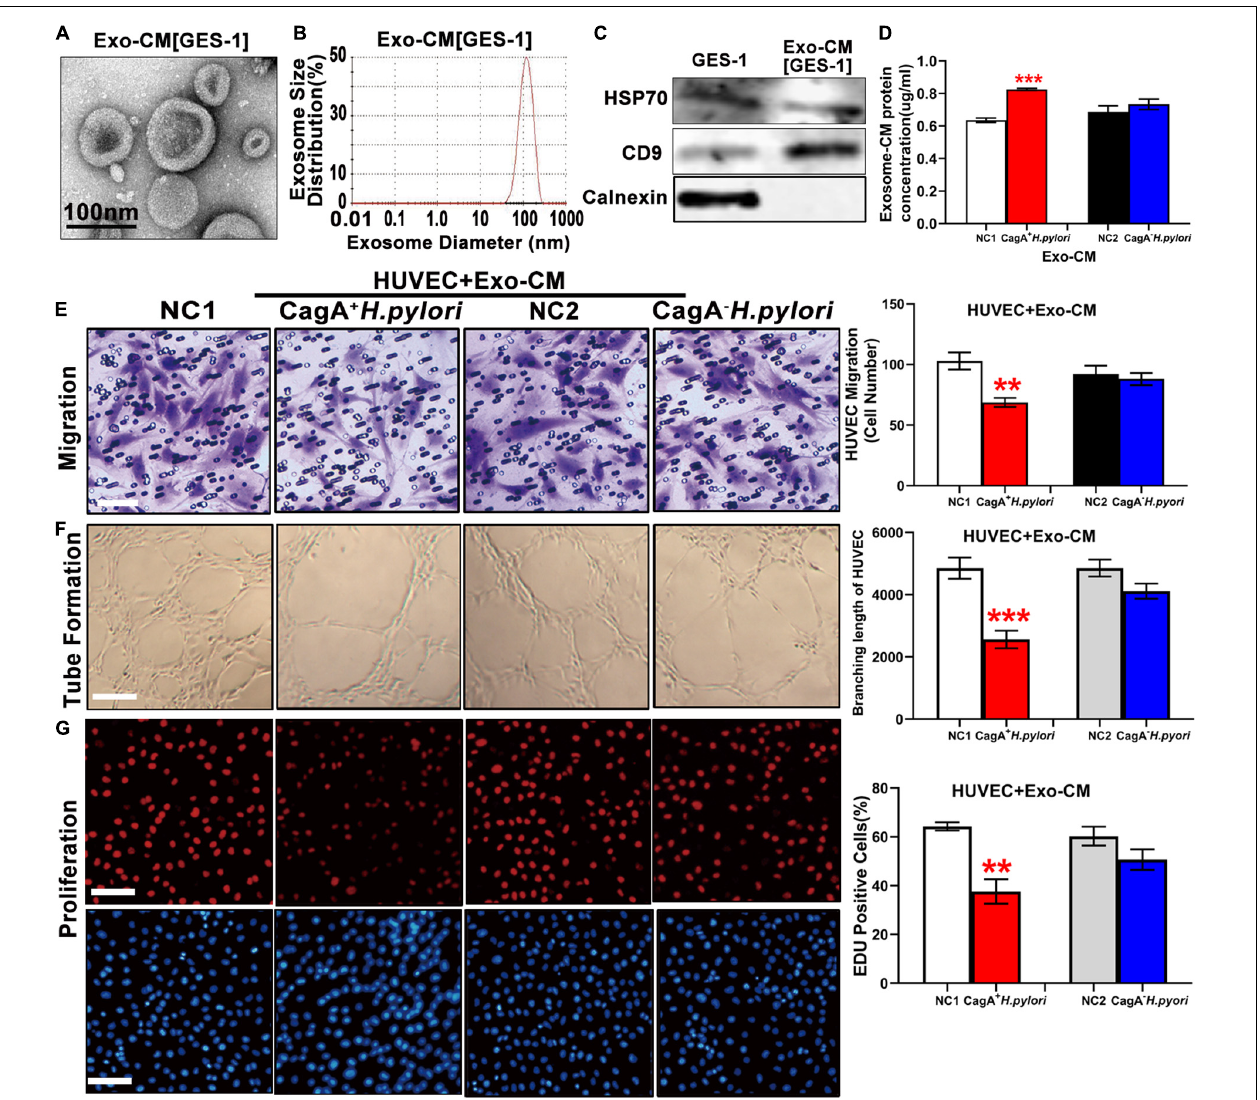
FIGURE 4 | Exosomes from conditioned medium of human gastric epithelial cells (GES-1) cultured with CagA + H. pylori , not with CagA − H. pylori , impaired endothelial function in vitro . Exosomes from conditioned medium of GES-1 cultured with CagA + H. pylori exhibited typical exosome morphology (A) and size distribution (B) . Western blotting analysis confirmed the presence of exosomes markers (HSP70, CD9) and absence of calnexin in exosomes (C) . Exosome protein concentration was significantly higher in the conditioned medium of GES-1 cultured with CagA + H. pylori than that cultured with CagA − H. pylori (D) . Treatment of HUVECs with exosomes-CM (100 ug/ml) from CagA + H. pylori , not from CagA − H. pylori , infected GES-1 significantly inhibited the function of HUVECs with decreased migration ( E , scale bars = 25 µ m), tube formation ( F , scale bars = 100 µ m), and proliferation ( G , scale bars = 100 µ m). NC(1/2): normal control; GES-1: human gastric epithelial cells; HUVEC: human umbilical vein endothelial cell; Exo-CM: Exosomes from conditioned medium. Data are presented as mean ± SEM; ** P < 0.01; *** P < 0.001 by t -test. Experiment was repeated 3 times for every measurement.